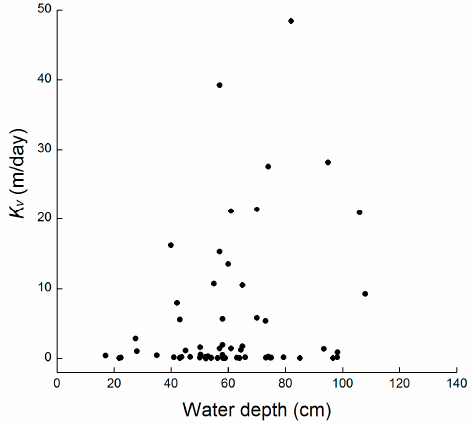
Figure 8. Relationship of K v and water depth.